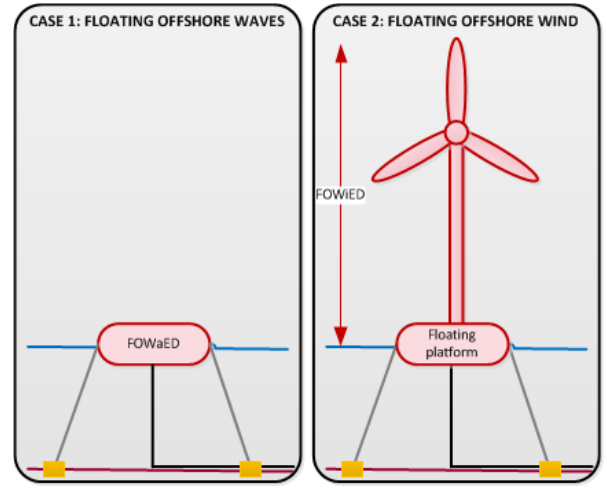
Figure 4. Cases considered.